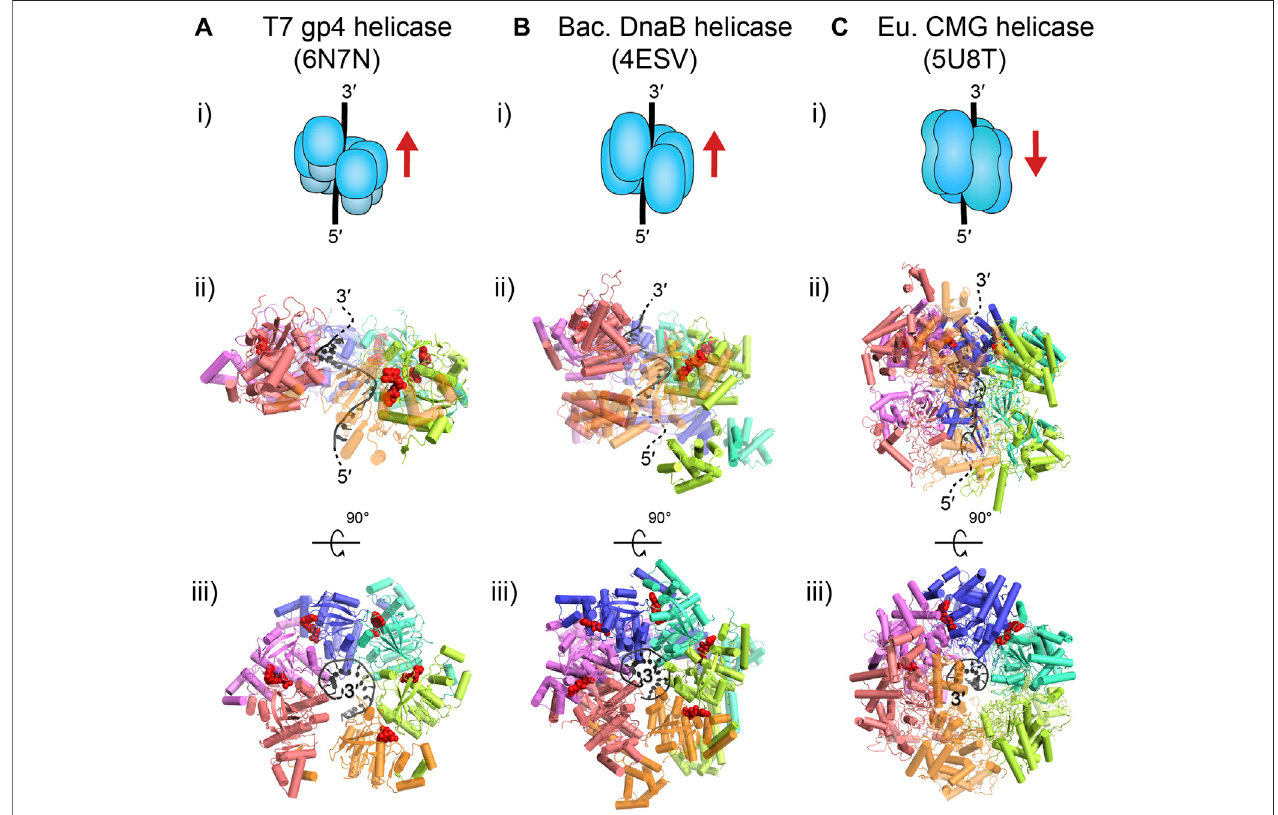
FIGURE 2 | Translocation states of the replicative helicases of interest. T7 gp4 (A) and E. coli DnaB (B) are homo-hexamers that move along ssDNA in the 5 ′ – 3 ′ direction (i) . Both of these prokaryotic, homologous helicases are thought to translocate in a spiral staircase conformation, where each subunit contacts 2 nt and moves sequentially along DNA (ii) ; gp4: PDB ID: 6N7N (note: thegp4 N-terminalprimase domain inthe structure has been omitted);DnaB: PDB ID: 4ESV (note: thelast orange subunit is semi-transparent). The top view of these structures (iii) shows that each subunit binds a nucleoside triphosphate molecule (red) at the subunit interface, except at the opening at the fi rst (pink) and last (orange) subunit. Note, structures of the T4 gp41 helicase are currently not available but are expected to be similar to gp4 (Mueser et al., 2010). The eukaryotic CMG replicative helicase (C) is a hetero-hexamer that moves along ssDNA in the 3 ′ – 5 ′ direction (i) . The MCM2 – 7 hexamer of CMG is expected to translocate in a bridged spiral conformation with the fi nal subunits closing the gap (ii) ; CMG: PDB ID: 5U8T (note: Cdc45 and GINS are omittedhere,andthelastorangesubunitissemi-transparent).ThetopviewofCMG (iii) showsonlytwosubunitsbindingnucleotides(red),eventhoughallsubunitshave binding